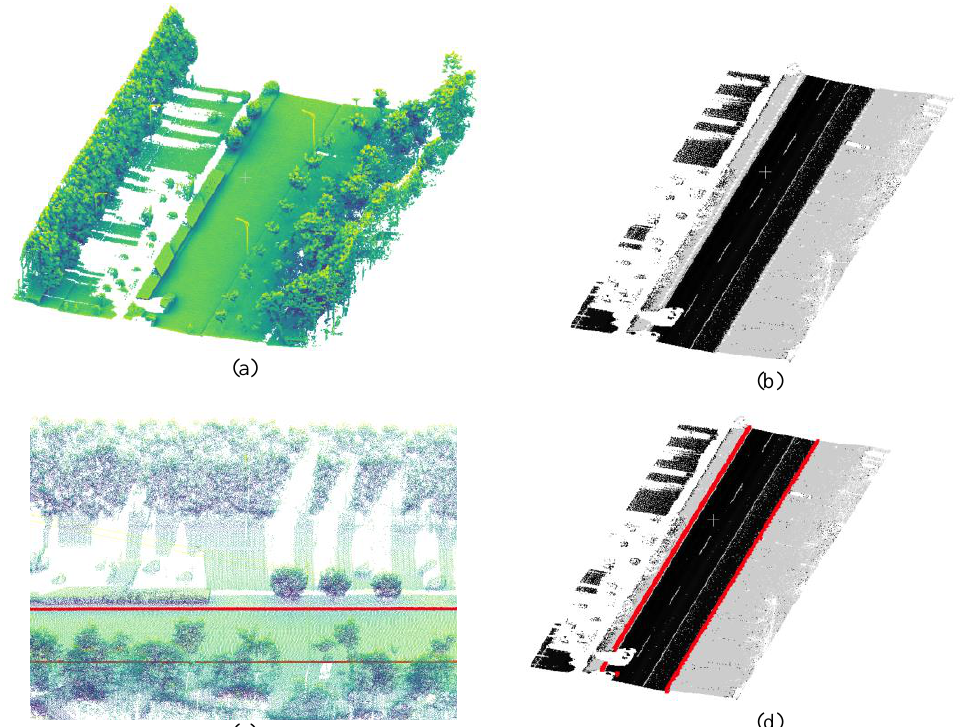
Figure 4. Extracted boundaries: (a) original point cloud; (b) ground; (c) curbs(red) and original data; (d) curbs(red) and